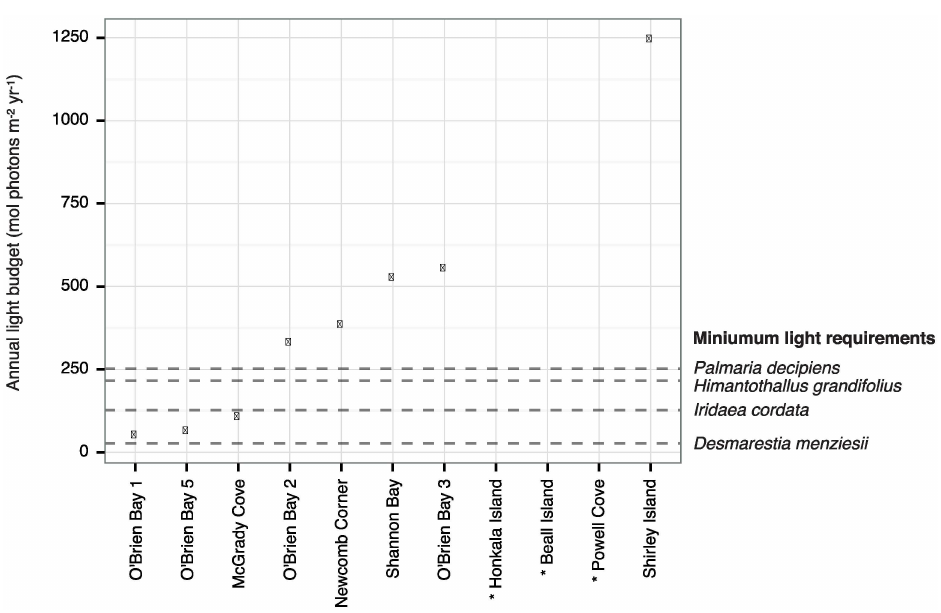
Fig 2. Annual light budgets (ALB) at the seabed. Points representALB recorded by light meters duringthe first year of deployment, and dashedlines are estimated minimumannuallight requirementsof four species of local algae (from Clark et al. 2013). Algae species are expectedto be viable at sites where the ALB is above their minimumrequirement.Light measurements are not available for three sites marked with * , but from long- term visual observation we know their annualtiming of sea-ice departureand therefore approximate light